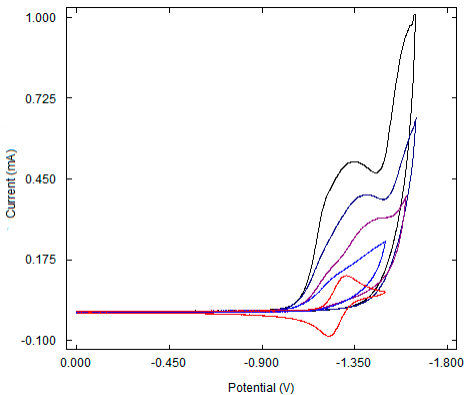
Scheme 20. Proposed reaction sequence in the electrocatalytic fluoroalkylation of α -methyl styrene using [Ni(tpy)Br 2 ], adopted from ref. [53].